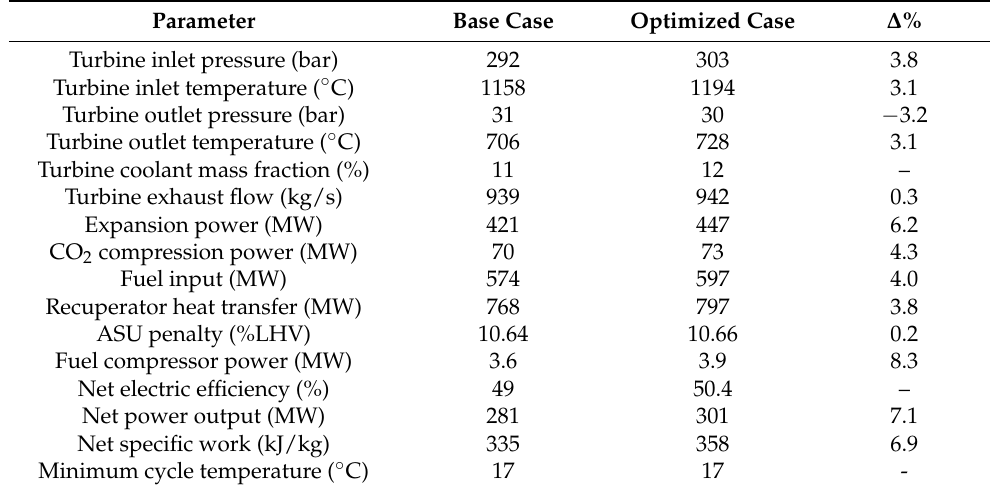
Table 3. Comparison between Allam cycle configurations: base case vs. optimized